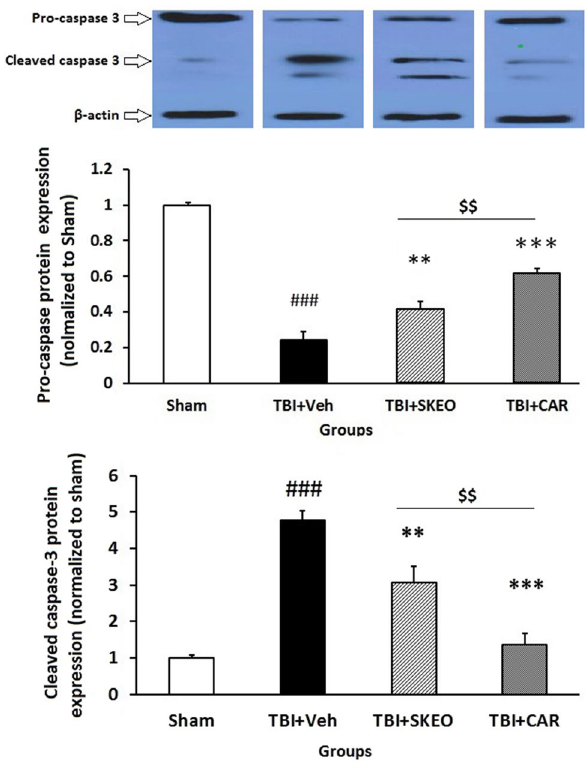
Figure 2. Effects of SKEO and CAR on the cleaved caspase-3 protein expression were assessed by western blotting 24 h after TBI induction in the different experimental groups (n = 6 rats per group). Cropped representative bands from the western blot test from the same run are shown above. Data are expressed as mean ± SEM. ### P < 0.001 represents significant difference with sham; ** P < 0.01 and *** P < 0.001 represent significant differences with TBI + Veh; $$ P < 0.01 represents significant difference between TBI + CAR and TBI + SKEO. TBI: Traumatic brain injury; SKEO: Satureja khuzistanica essential oil; CAR: